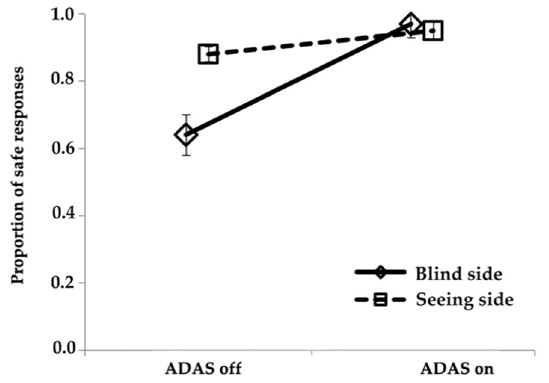
Figure 9. Proportion of safe responses for HVFD participants by whether the ADAS was on or off and whether the crossing was from the participant’s blind or seeing side (mean, SEM).